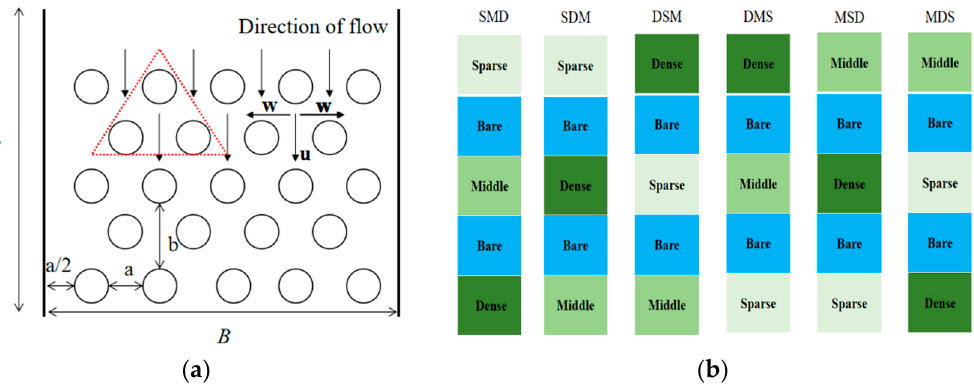
Figure 2. Vegetation configurations: ( a ) Vegetation distribution in a staggered pattern; ( b ) Density configurations in at the summit, backslope and footslope. Table 1. Main data of the experiments.